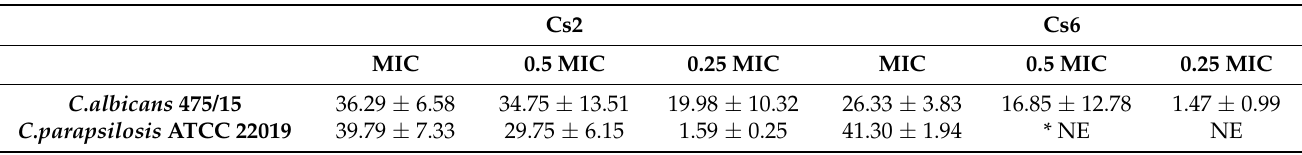
Table 7. Antibiofilm activity of C. spicatum extracts, results are expressed as a percentage of inhibition of biofilm formation.